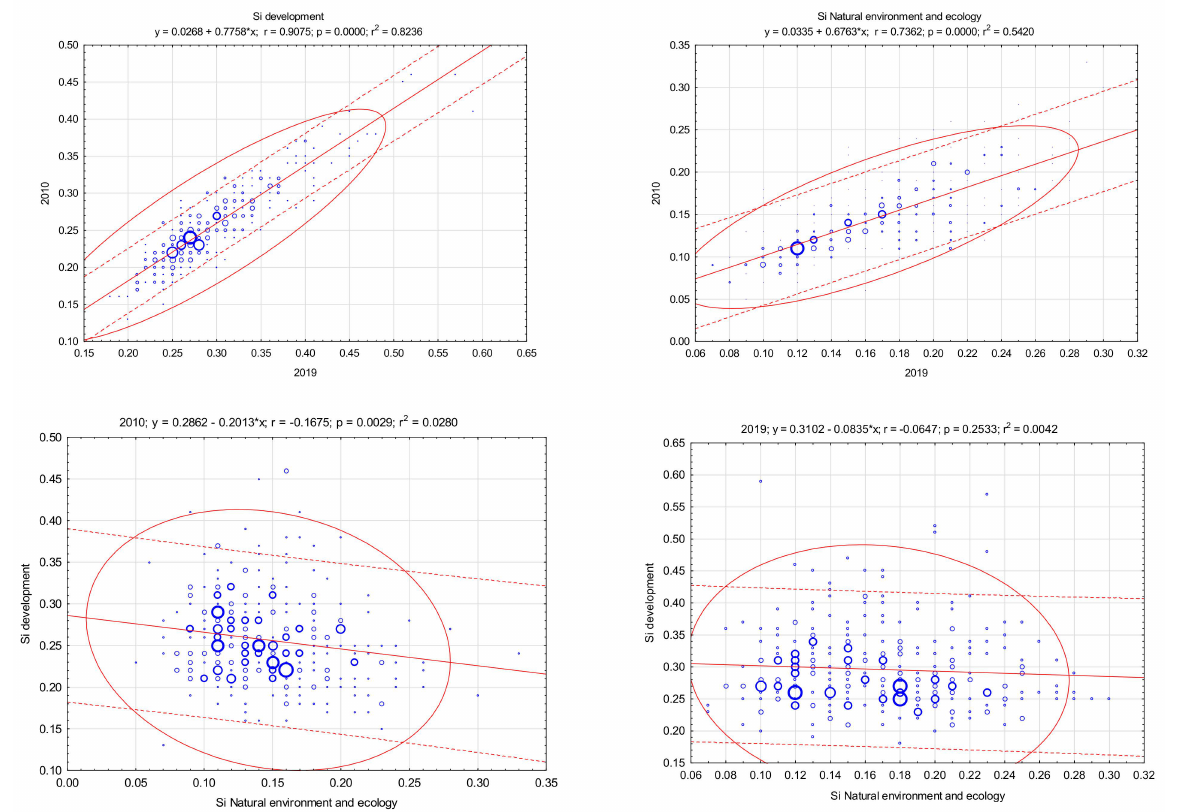
Figure 4. Dispersion of the synthetic measure of the financial situation as well as the demographics and labor market of poviats in Poland in 2010 and 2019. Source: study based on BDL CSO